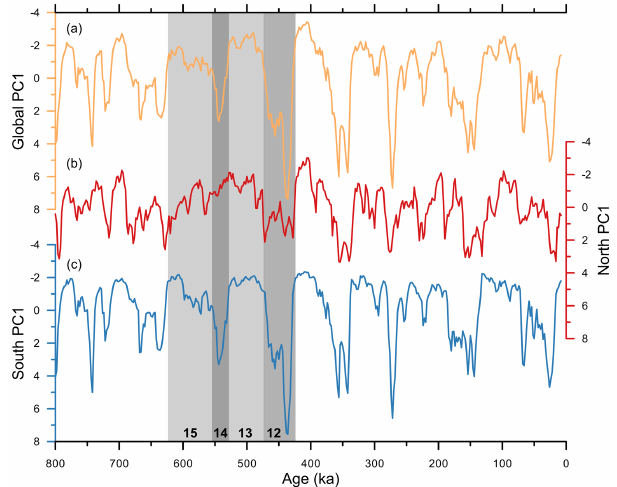
Figure 6. Dust principal components. The first principal compo- nents of our dust analysis for the global (yellow), north (red), and south (blue) records. Vertical gray boxes highlight specific glacial (dark gray) and interglacial (light gray) periods. The numbers indi- cate the associated MIS of each box.